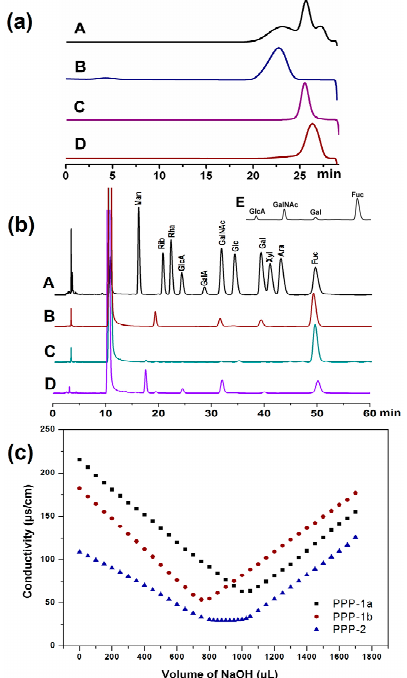
Figure 3. HPLC profiles of PPP (A), PPP-1a (B), PPP-2 (C) and PPP-1b (D) ( a ), chromatograms of PMP derivatives of mixed monosaccharide standards (A), PPP-1a (B), PPP-1b (C), PPP-2 (D) and PPP (E) ( b ), and conductimetric titration curves of PPP-1a, PPP-1b and PPP-2 ( c ).